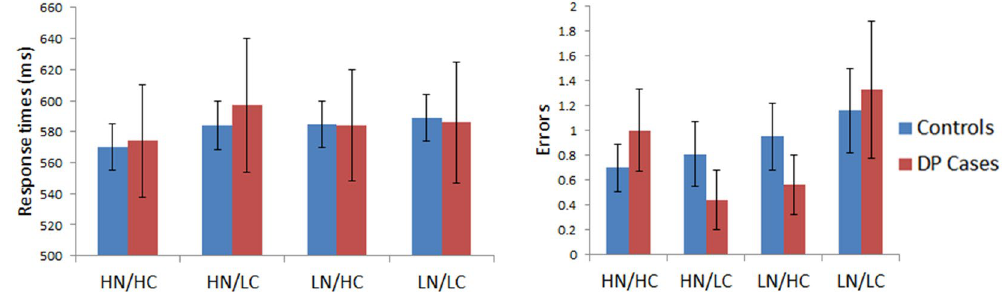
Figure 8. Results for Reading Aloud: N Confusability. Data are shown in left panel (response time) and right panel (number of errors) for control and DP groups. Error bars indicate ± SEM. The four conditions are words of high n/high confusability (HN/HC), high n/low confusability (HN/LC), low n/high confusability (LN/HC), and low n/low confusability (LN/LC).